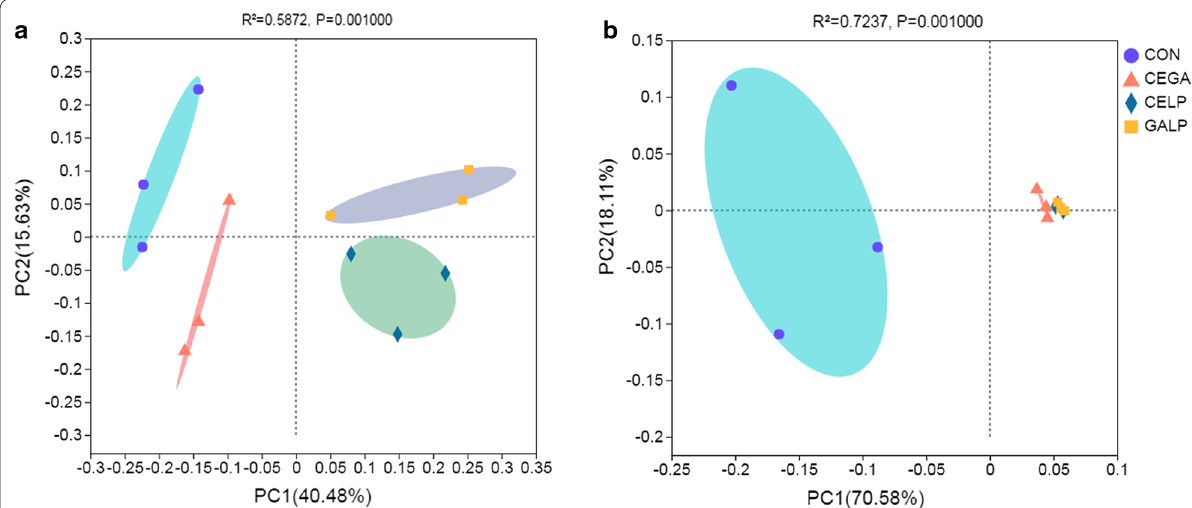
Fig. 1 Principal coordinate analysis (PCoA) of the bacterial communities based on unweighted ( a ) and weighted UniFrac ( b ) at the OTU level. CON untreated silage, CEGA cellulase plus ɑ -galactosidase, CELP cellulase plus L. plantarum , GALP ɑ -galactosidase plus L.